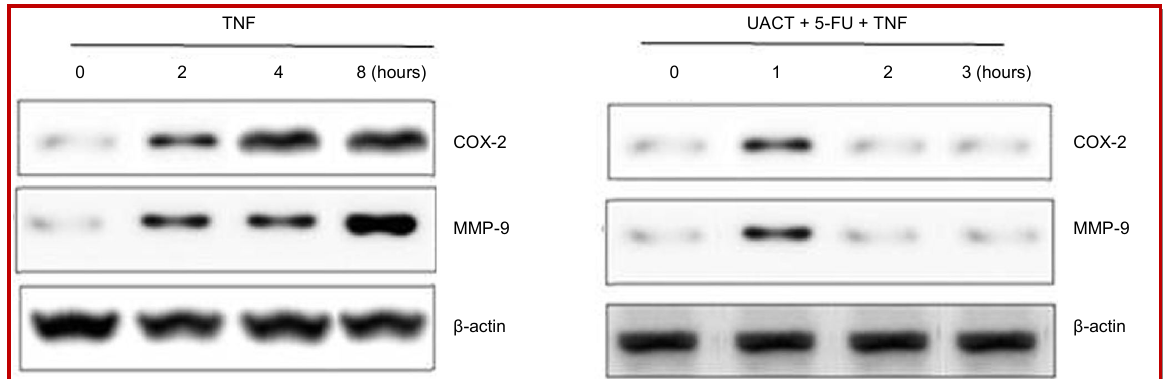
Figure 5: Sequential treatment with combination of UACT followed by 5-FU inhibited induction of COX-2 and MMP-9 by TNF H209 cells (2 x 10 6 cells/mL) were left untreated or incubated with 50 µM UACT for 72 hours and then treated with 0.1 nM TNF for different time periods. Whole-cell extracts were prepared and analyzed by Western blotting using antibodies against COX-2 and MMP-9. B, UACT inhibited TNF- induced cyclin D1. H209 cells (2 x 10 6 cells/mL) were left untreated or incubated with 50 µM UACT for 72 hours and then treated with 0.1 nM TNF for different time periods. Whole-cell extracts were prepared, and 80 µg of the whole-cell lysate were analyzed by Western blotting using antibodies against cyclin D1. Combination of UACT and 5-FU inhibited the induction of COX-2 and MMP-9 by TNF through synergistic FU-pretreated cells showed 95% inhibition of TNF- induced NF- k B-depen-dent SEAP expression was observed at just 50 µM concentration of UACT. These results demonstrate synergistic effect of 5-FU on UACT.